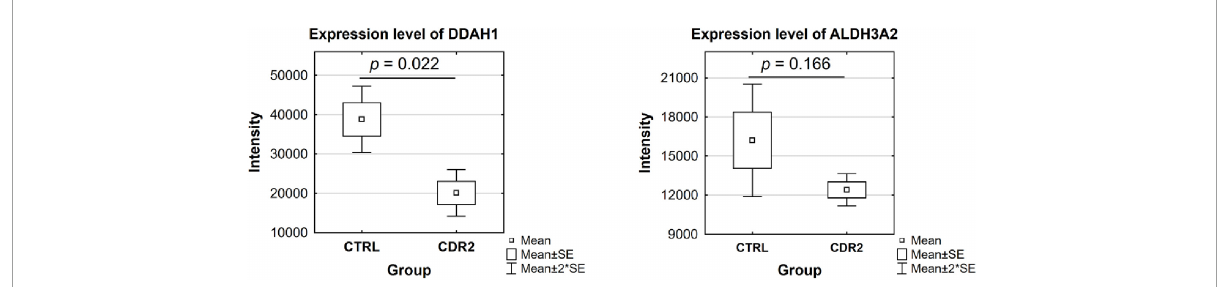
FIGURE6 Validation of marker proteins DDAH1 and ALDH3A2 by microarray technology. The box plots highlight the expression level of the proteins validated by microarray. The selected proteins show similar trends to the results obtained by MS analysis. DDAH1 was identified with significantly lower abundance in the CDR2-treated group compared to untreated CTRL ( p < 0.05). The ALDH3A2 protein showed a tendency to be lesser expressed in the CDR2-treated explants compared to CTRL but was not supported by statistical significance ( p >